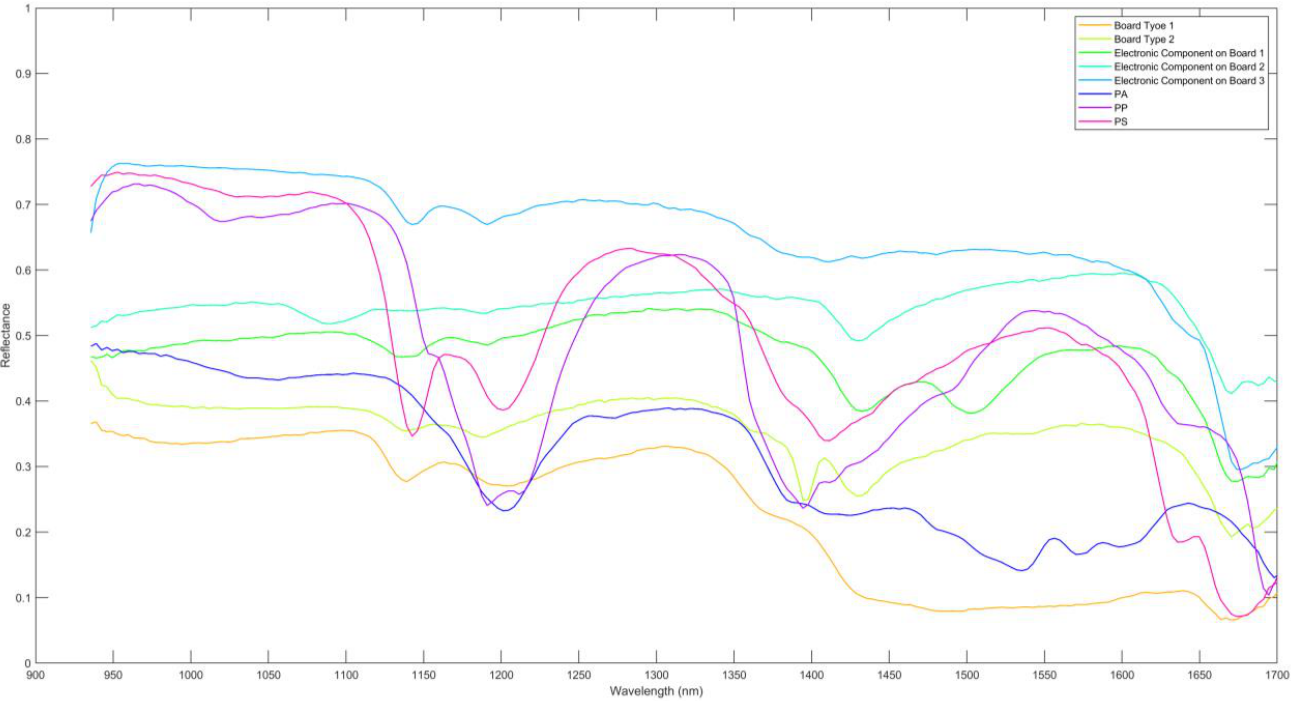
Figure 10. Spectral signatures used for the classification. As a result, the rule defined for a category is specific to that category and there is no possibility of confusion because the shapes are distinct enough. Such rules can therefore only be used if the shapes of the spectral curves are all sufficiently different.